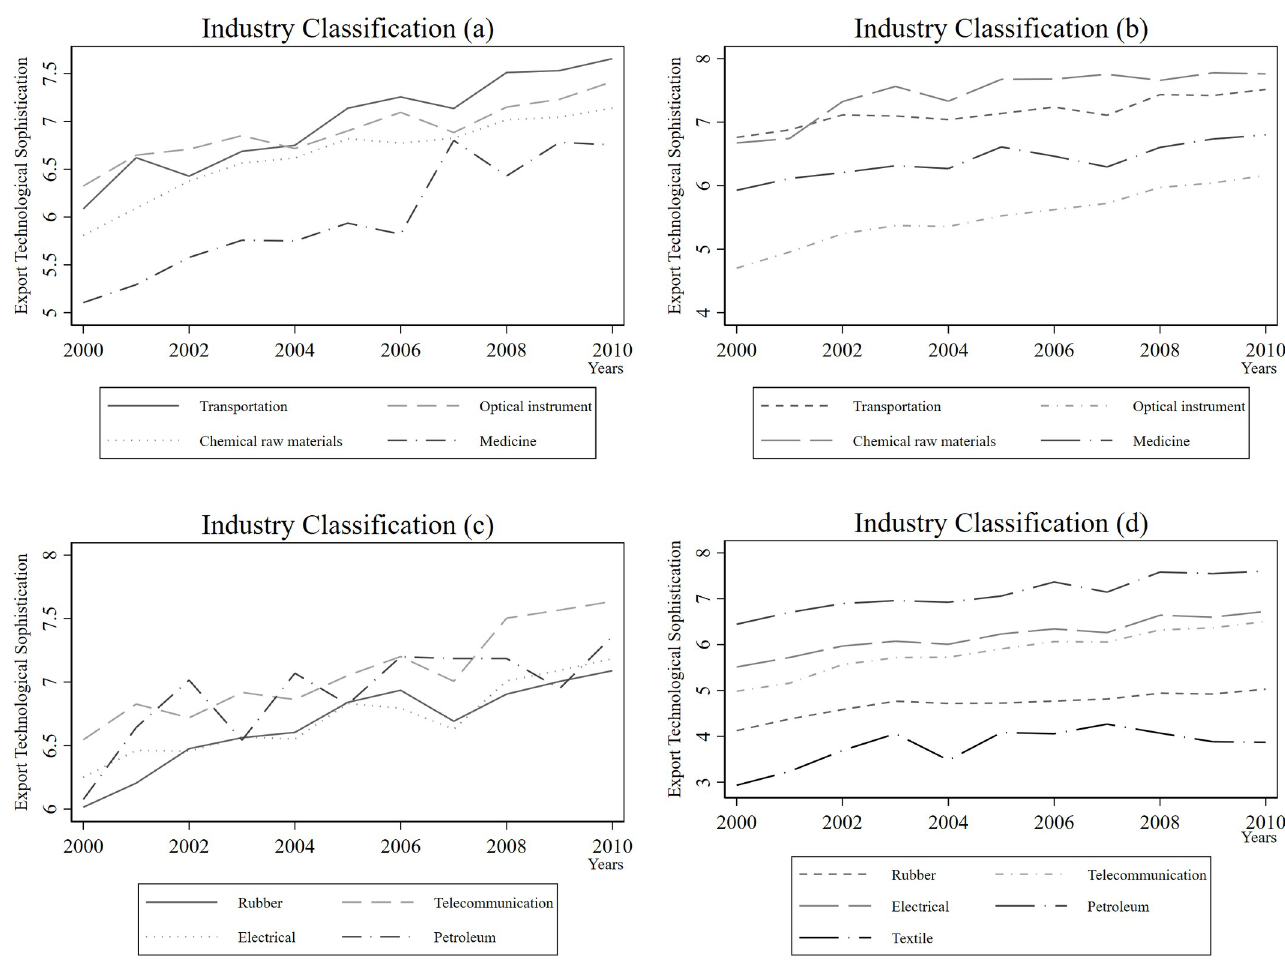
Fig 2. The trend of export technological sophistication in